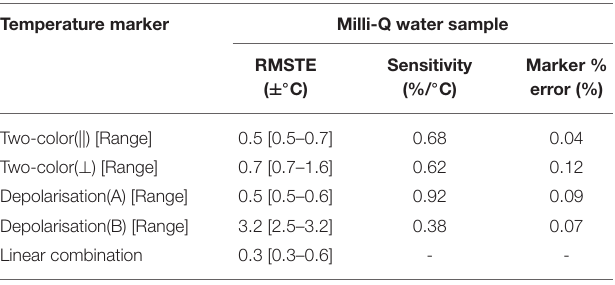
TABLE 2 | RMSTEs ( ± ◦ C), sensitivities (% change/ ◦ C), and absolute percentage errors in markers (%) for a Milli-Q water sample.